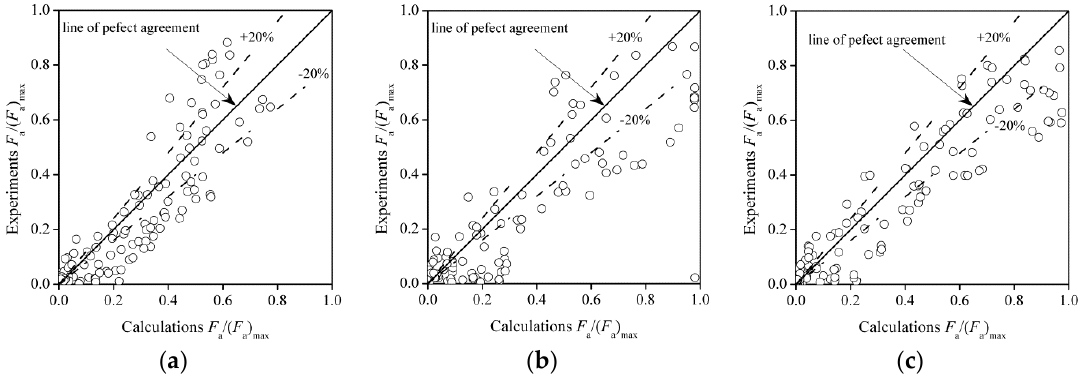
Figure 15. Comparison of experimental data with calculated values of dimensionless bubble frequency. ( a ) upper nappe; ( b ) lower nappe; ( c ) side nappe.